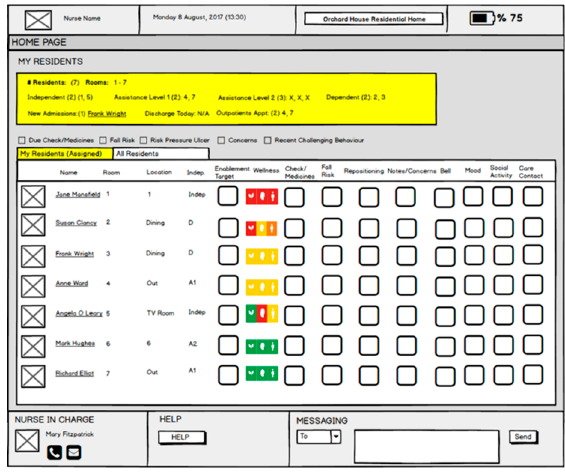
Figure 5. Prototype of dashboard of nurse tablet solution featuring wellness indicator.